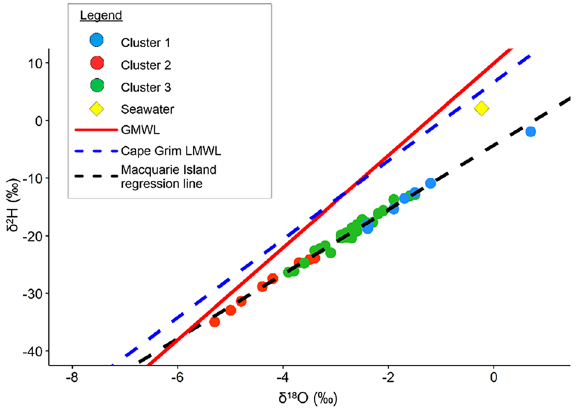
Figure 4. Difference between Macquarie Island Lake water samples (δ 2 H = 5.6 δ 18 O − 4.3), the global meteoric water line (GMWL, δ 2 H = 8 δ 18 O + 10) and Cape Grim local meteoric water line (LMWL, δ 2 H = 6.8 δ 18 O + 6.65). (Cluster groupings from Fig.